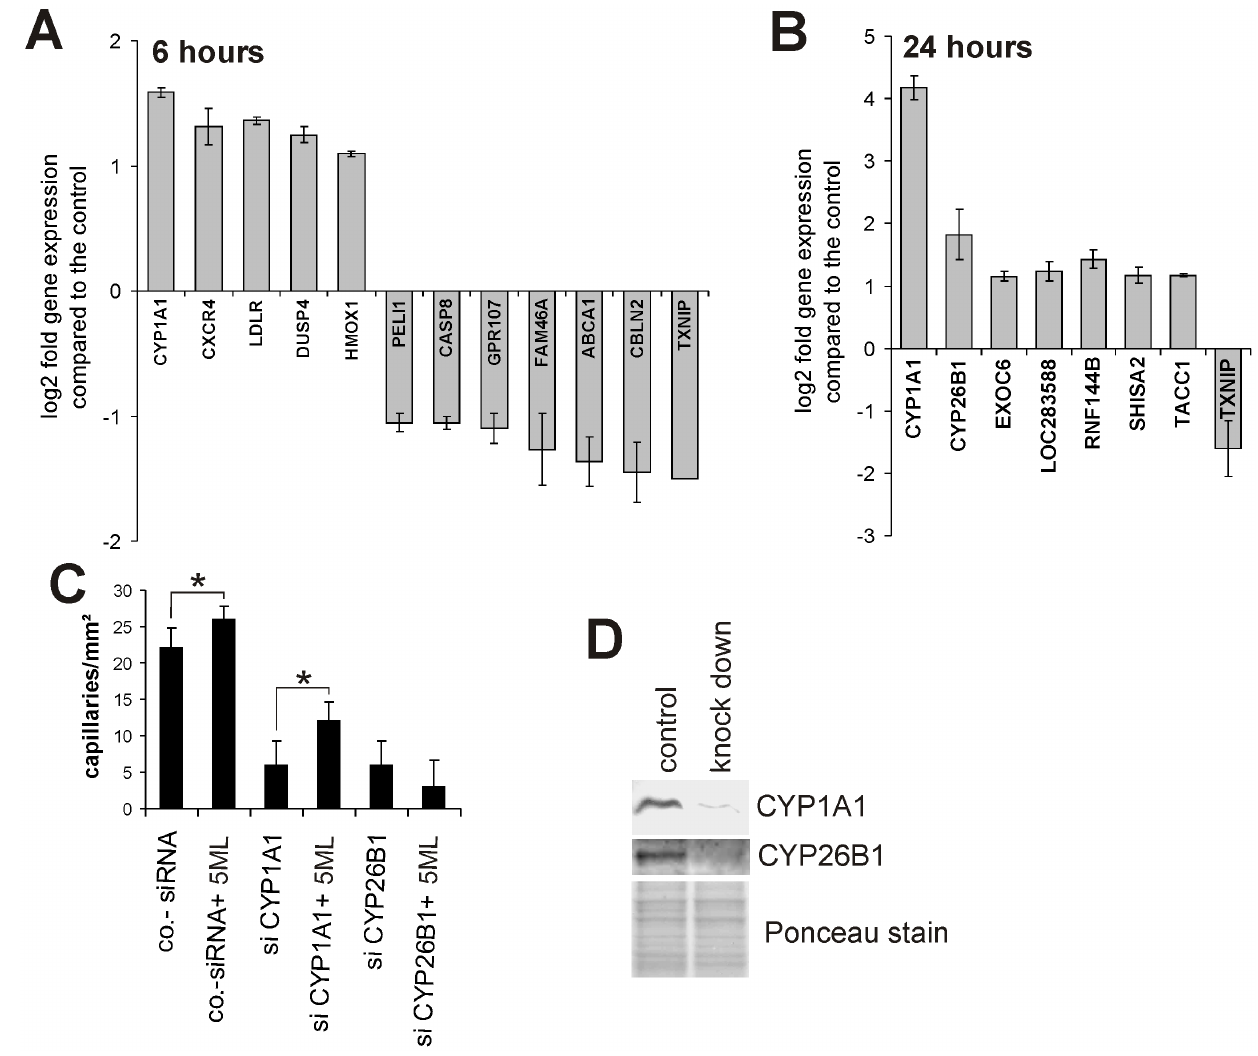
Figure 3. 5ML alters the transcription of a small set of genes; CYP26B1 is the causal mediator of 5ML -induced angiogenesis. Figures 3A and 3B show median values + / 2 S.D. of microarray-based analyses of gene-regulation by 5ML in relation to controls 6 and 24 hours after the addition of 5ML (10 m M). Figure 3C shows that despite the fact that the knockdown of CYP1A1 had a significant inhibitory effect on spontaneous angiogenesis in HUVECs; CYP1A1 knockdown had no effect on angiogenesis increased by 5ML. Similarly, CYP26B1 knockdown potently repressed spontaneous angiogenesis in HUVECS and in addition completely abrogated 5ML-induced tube formation. Shown are mean values of two independent experiments performed in triplicates + / 2 SD. * p , 0.05. Figure 3D shows Western blot analyses of effects of the CYP1A1- and the CYP26B1-specific knockdown on protein expression of the corresponding proteins. Asterisks indicate significant differences (* p , 0.05) compared to the corresponding controls.